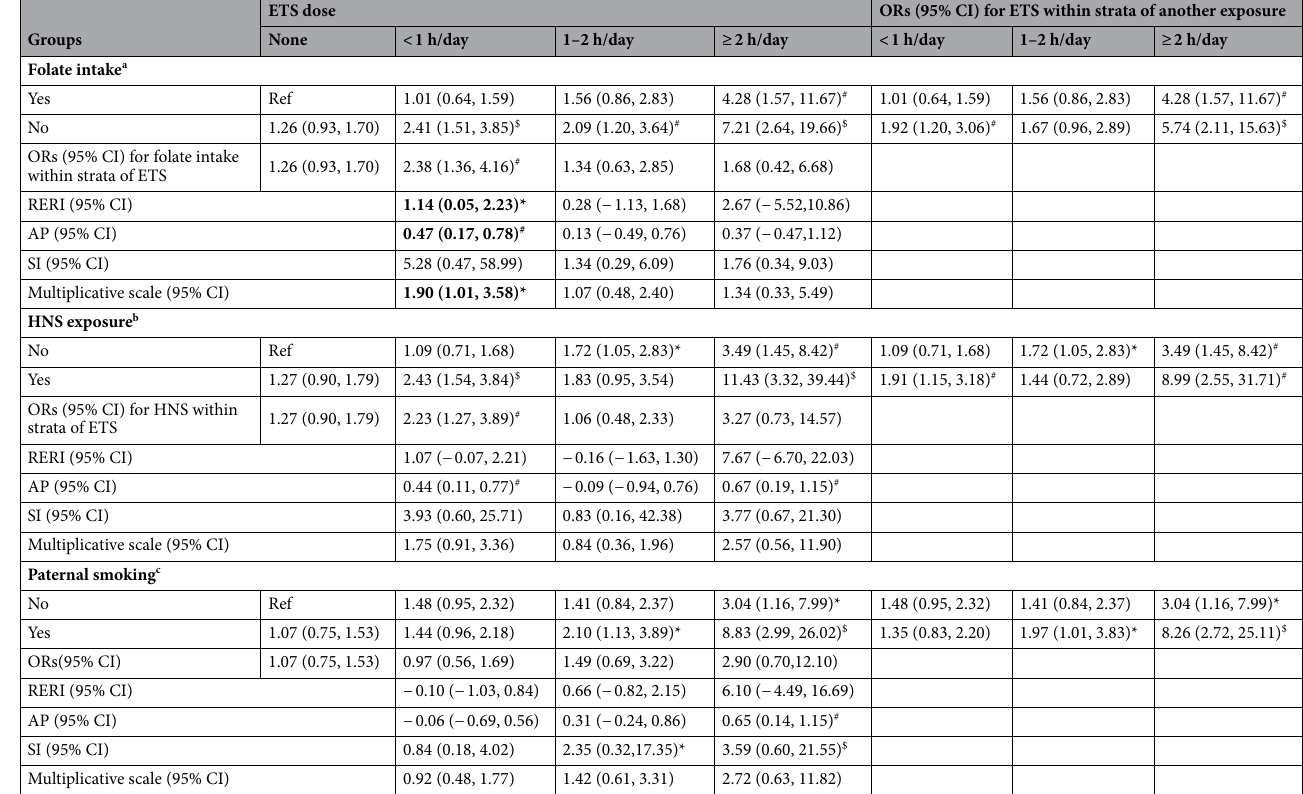
Table 4. Interaction between maternal ETS exposure and parental factors on the risk of CHDs. *p < 0.05; # p < 0.01; $ p < 0.001. a Adjusted by maternal age, maternal education level, residence, congenital anomalies family history, maternal HNS exposure, paternal smoking. b Adjusted by maternal age, maternal education level, residence, maternal folate intake, congenital anomalies family history, paternal smoking. c Adjusted by maternal age, maternal education level, residence, maternal folate intake, congenital anomalies family history, maternal HNS